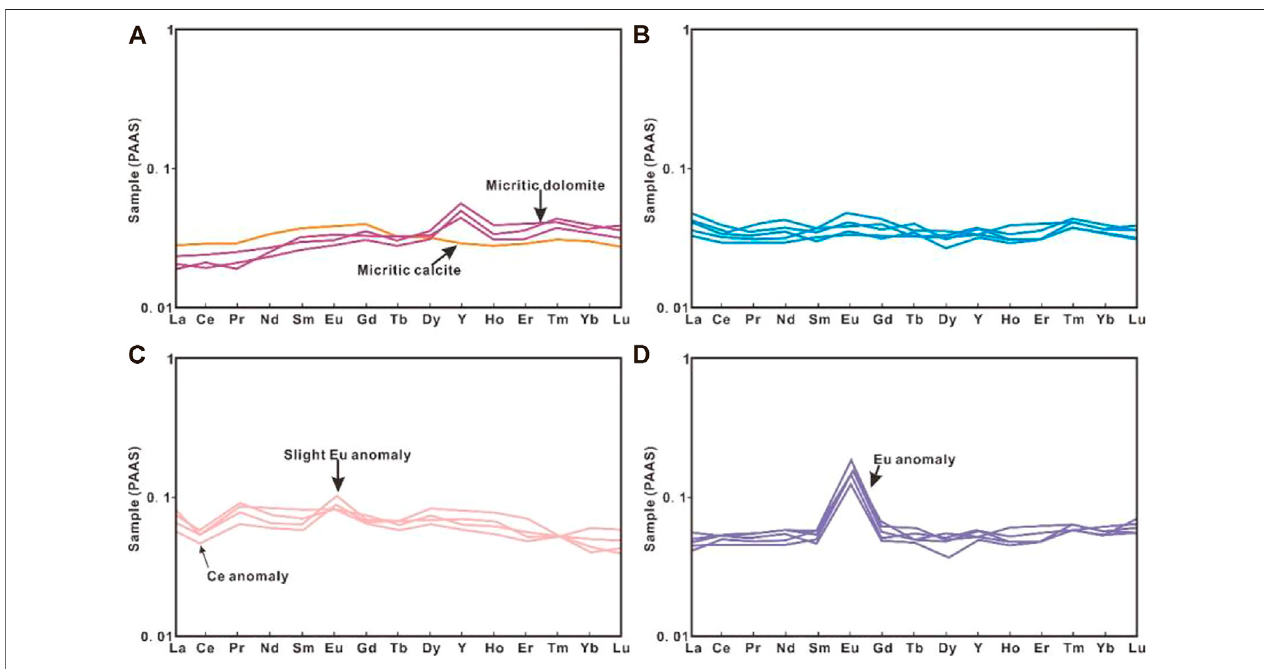
FIGURE 6 | Distribution patterns of the rare earth elements in different types of dolomites or calcites. (A) Micritic dolomites and calcites. (B) Fine-to medium-sized dolomites. (C) Medium-to coarse-sized dolomites. (D) Dolomite cements. All samples are normalized to PAAS standard (Gromet et al., 1985).